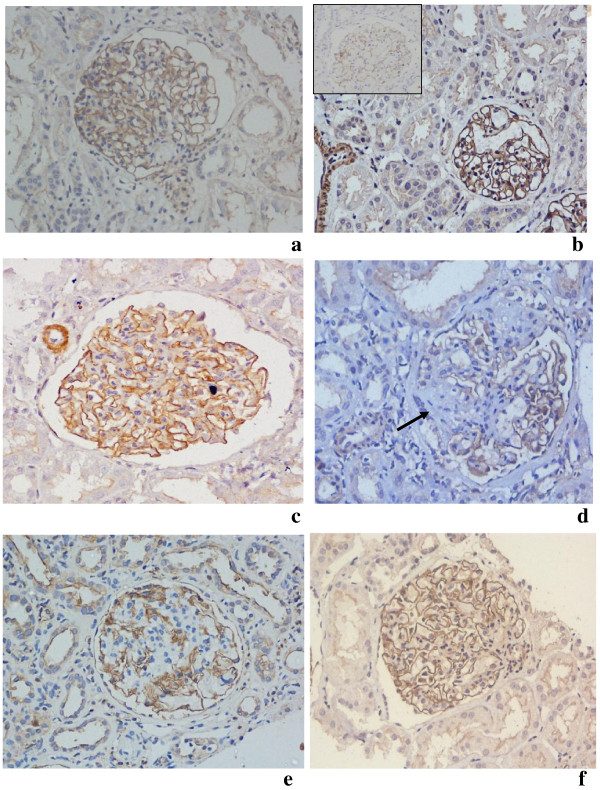
Photomicrograph shows podocin expression (2+) in all except 1+ intensity in MCD (inset b) and loss of staining in FSGS (d) a) control b) MCD c) & d) FSGS e) IgAN f) MGN) IHC, Podocin, X20.